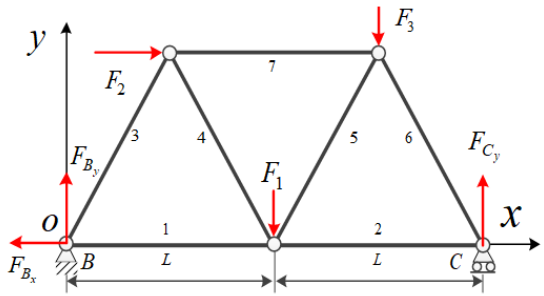
Figure A1. Overall force figure of a seven-bar truss.